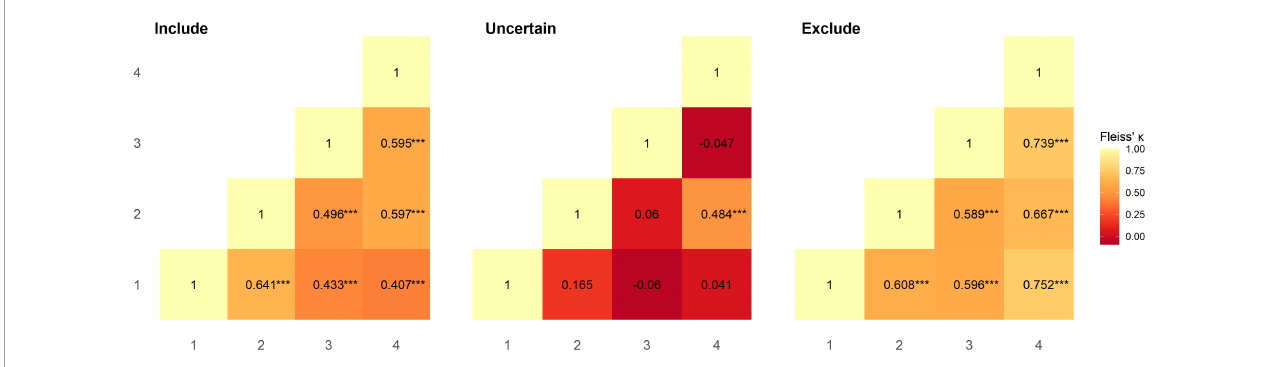
FIGURE1 Reliability between pairs of raters for each category was assessed using Fleiss’ Kappa. Agreement between raters at significantly greater than chance level is denoted as *** p < 0.001.